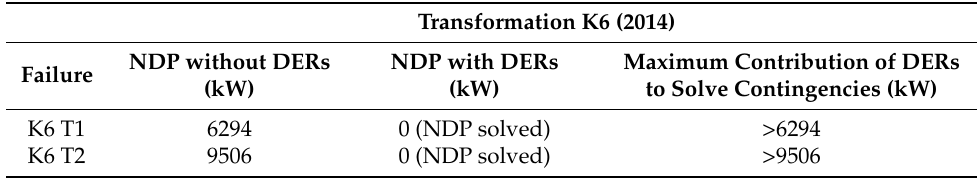
Table 2. Transformation K6 under contingency: DER ancillary services